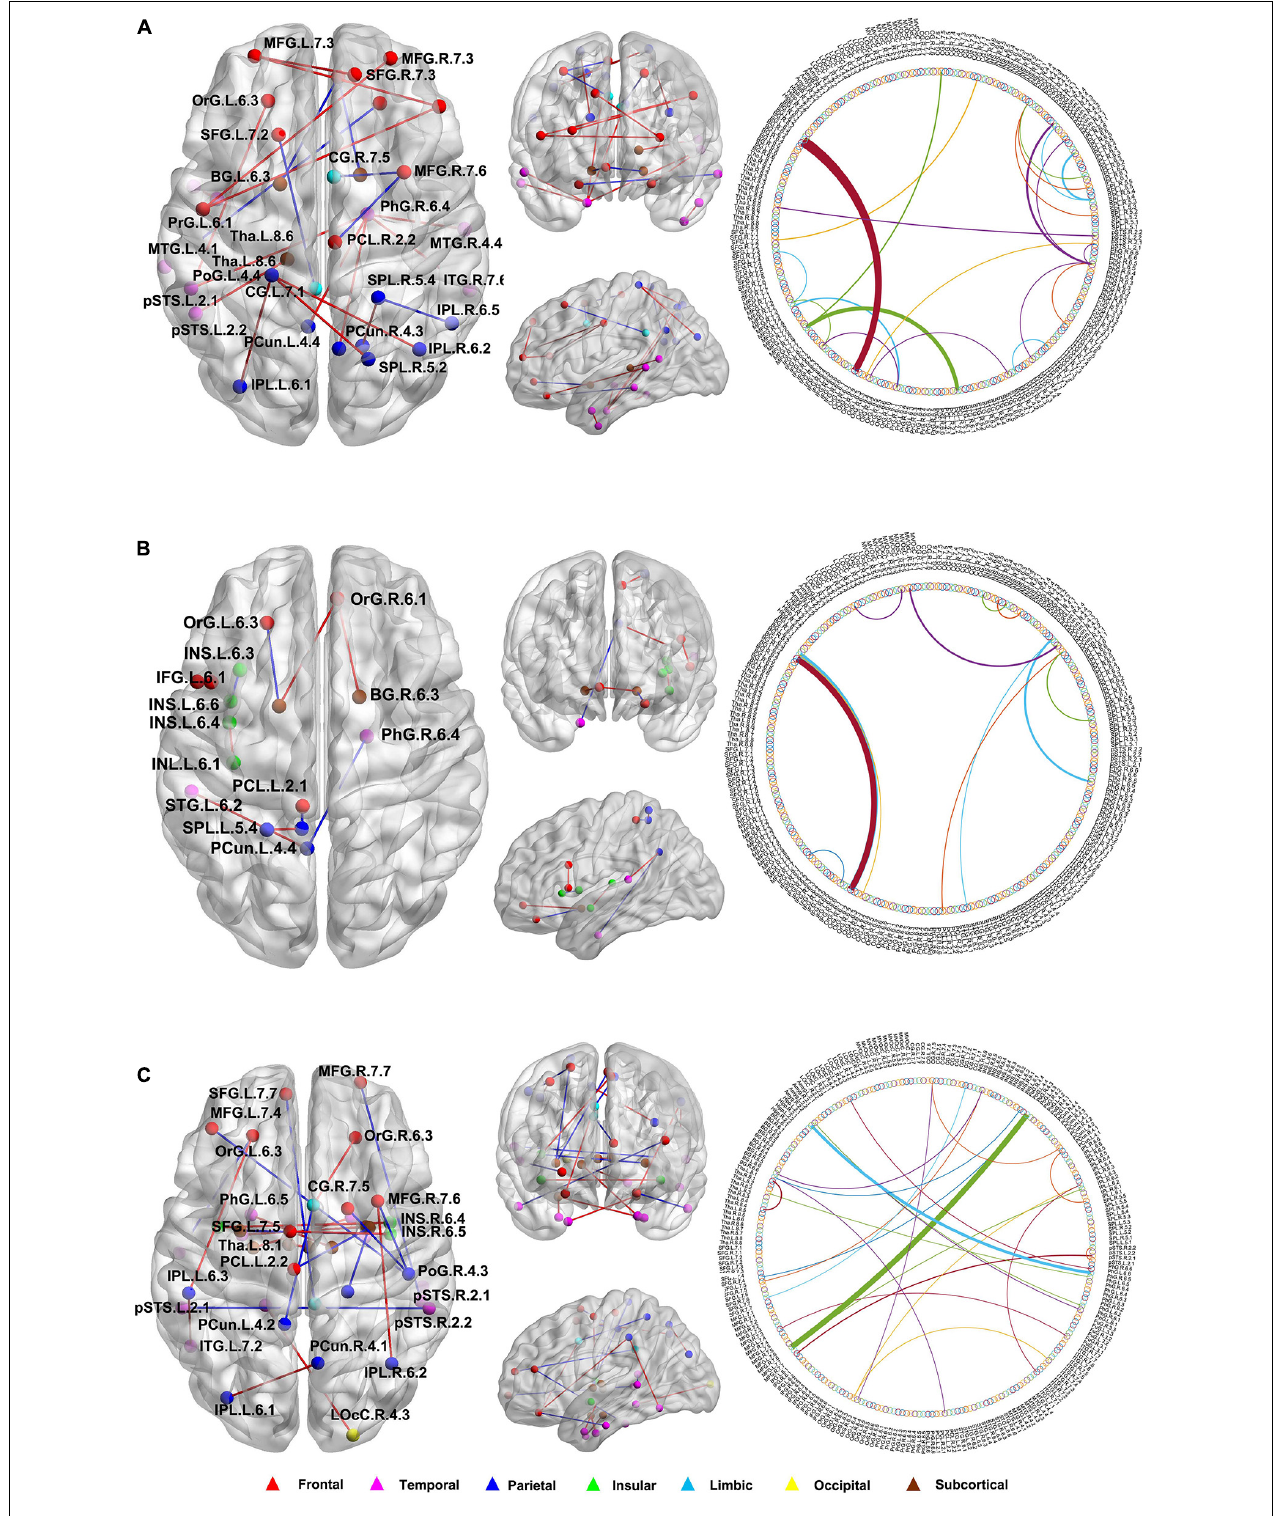
FIGURE 5 | The distribution of consensus connections identified by different modalities. (A) Morphological brain network based on sMRI; (B) Structural brain network based on DTI; (C) Functional brain network based on fMRI. The consensus connections were mapped on the ICBM 152 template with the BrainNet Viewer package (http://nitrc.org/projects/bnv/). Red and blue lines represent the increased and decreased connectivity weight of the SCD group, respectively. sMRI, structural magnetic resonance imaging; DTI, diffusion tensor imaging; fMRI, functional magnetic resonance imaging.